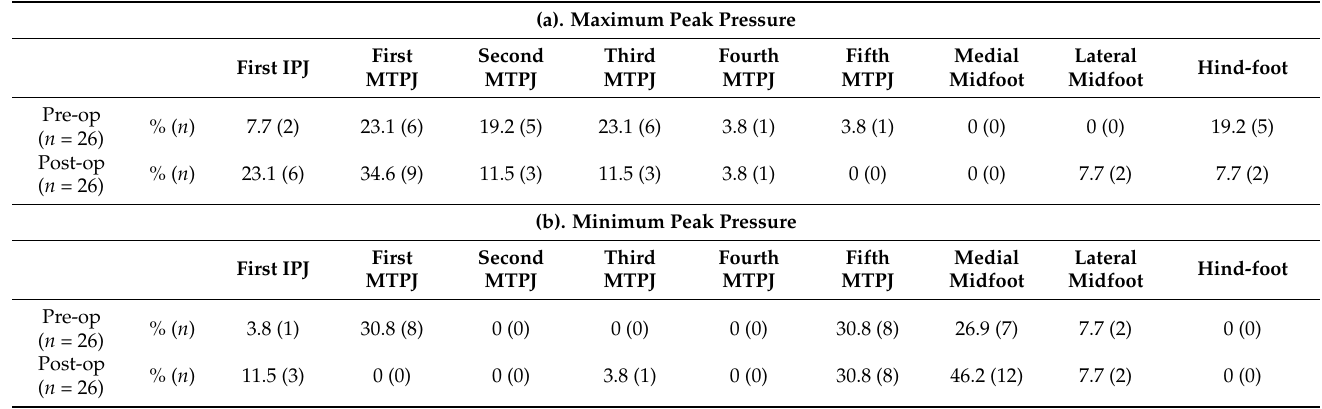
Table 3. Percentage in which a maximum peak pressure value or a minimum peak pressure value occurred in each of the nine